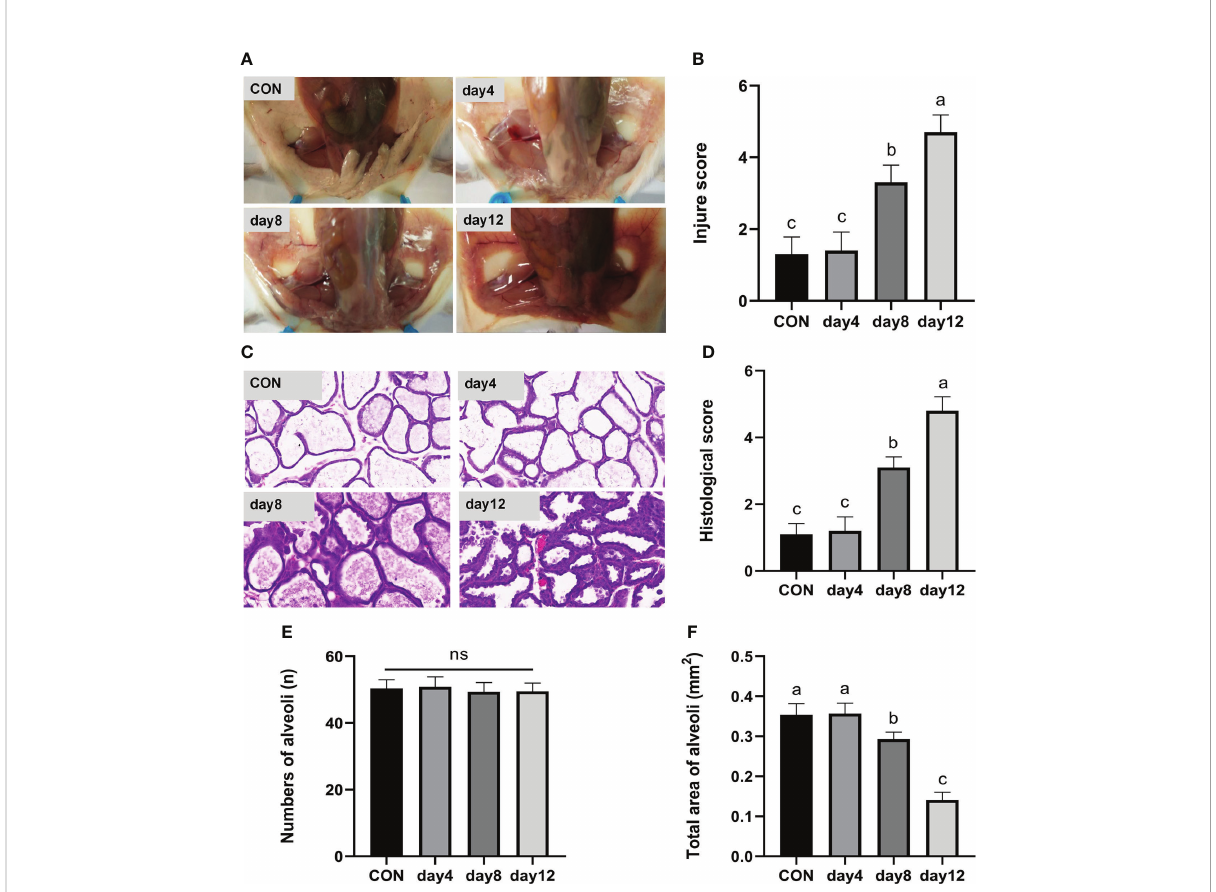
FIGURE 4 Effects of HS on mammary gland tissue of mice (n = 12). (A) Mammary gland tissue surface. (B) Clinical score. (C) hematoxylin-eosin-stained pathological sections. (D) Histological score. (E) Number of alveoli. (F) Total area of alveoli. a-c Different lowercase letters indicate extremely signi fi cant differences between two groups ( P < 0.01), while the same lowercase letters indicate no signi fi cant difference between two groups ( P > 0.05).